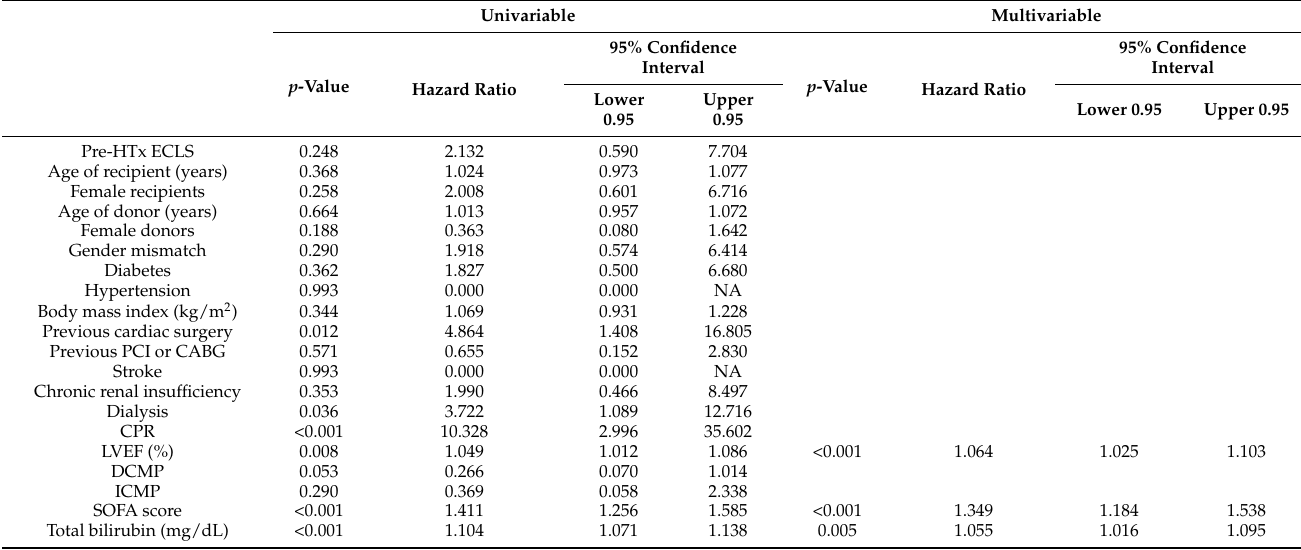
Table 3. Independent predictors of 30-day mortality after IPTW.